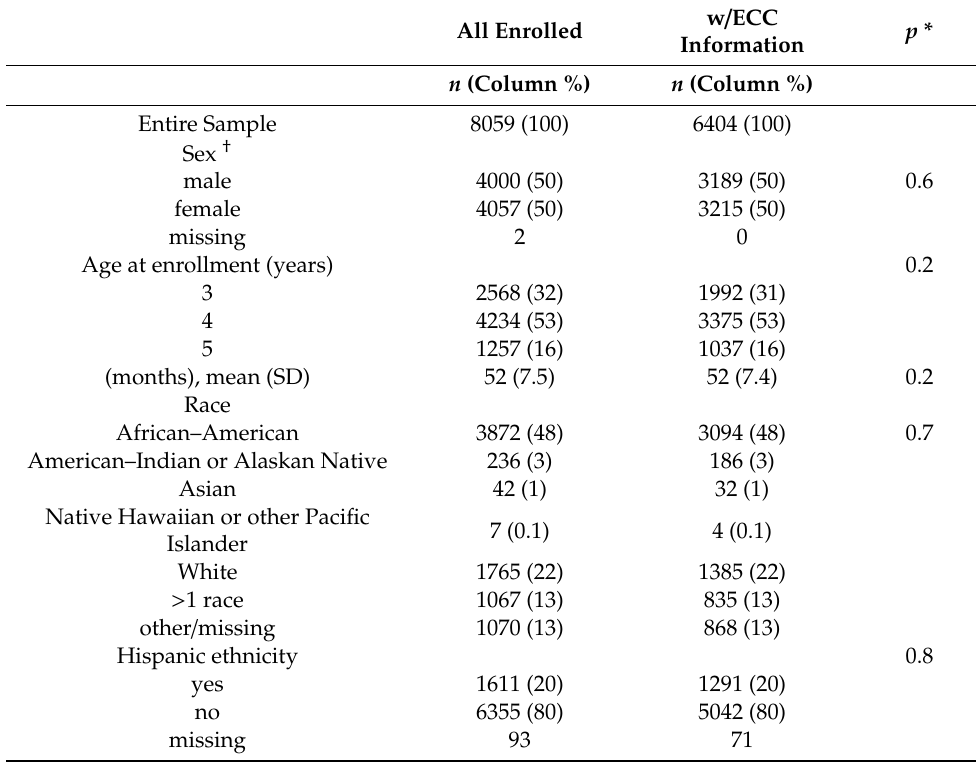
Table 3. Demographic characteristics of all participants enrolled and all participants that provided early childhood caries (ECC) information via clinical examinations in the ZOE 2.0 study, North Carolina,